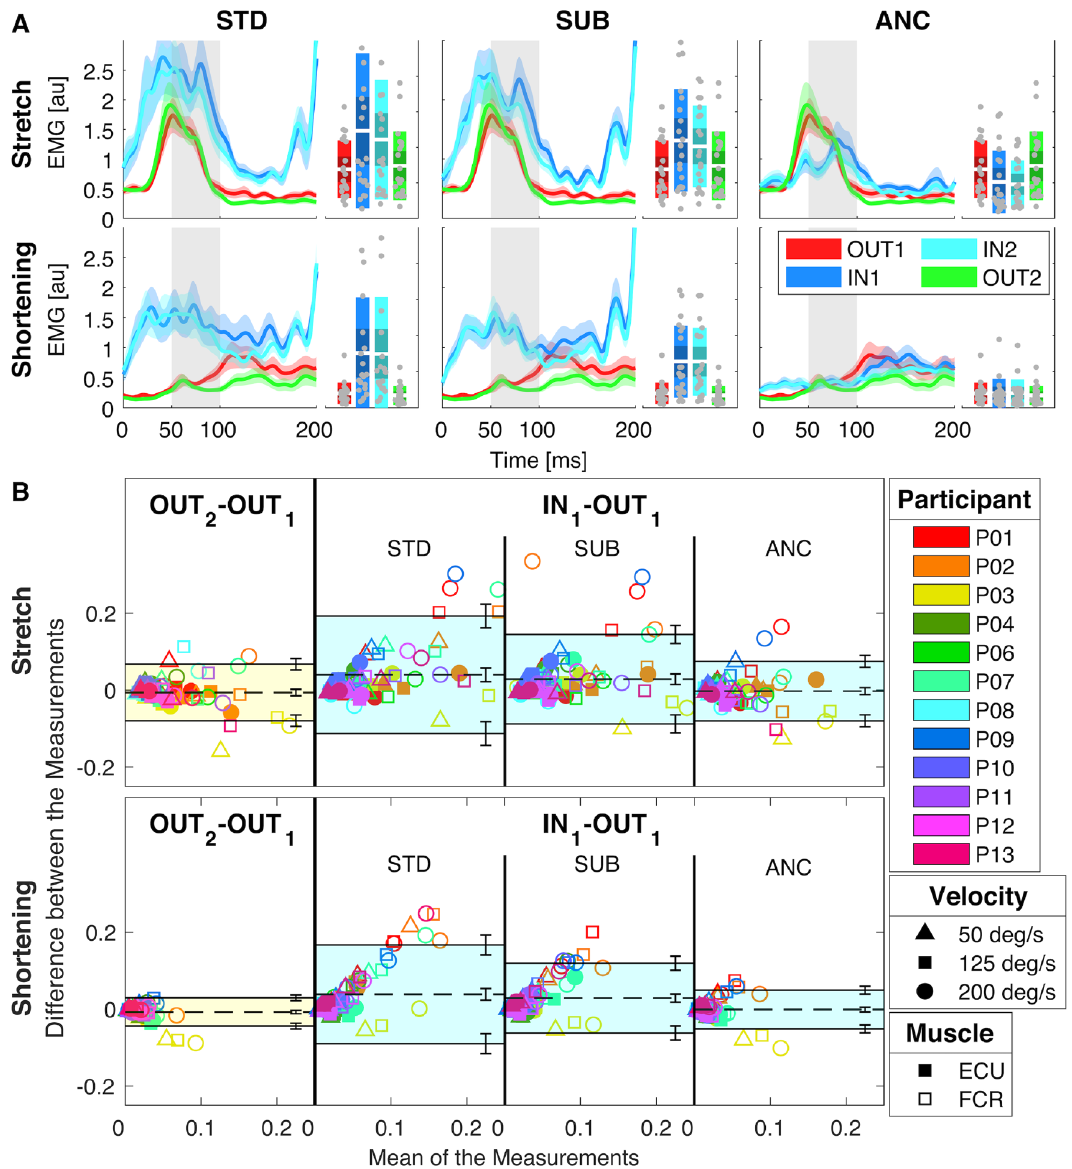
Figure 2. ( A ) Group-average of the stretch-evoked EMG signal measured using different processing pipelines in response to a 200 deg/s ramp-and-hold perturbation for both muscles undergoing stretch or shortening for Experiment 1. Plots are obtained using the same electrode set and different processing pipelines: standard (STD), a time-domain subtraction of measured and reference signals (SUB), and adaptive noise cancellation (ANC). In all graphs, the thick line represents the group mean and the shaded area the 95% confidence interval of the group mean. The gray shaded area indicates the time interval where an LLR is expected. Box plots indicate the distribution of LLR amplitude, with indications for the mean (white horizontal line), mean ± one st. dev. (dark shaded area), 95% confidence interval (light shaded area), with individual measurements overlaid. ( B ) Bland–Altman plots for the comparisons OUT 2 vs. OUT 1 (left) and IN 1 vs. OUT 1 (right) when different filtering pipelines are considered. Datapoints in each plot encode participants with colors, perturbation velocities with shapes, and muscles with filling style. The shaded area represents the interval between the negative and positive limits of agreement, while the dashed line indicates bias. Error bars on the side of each plot represent the 95% confidence intervals by which each parameter is